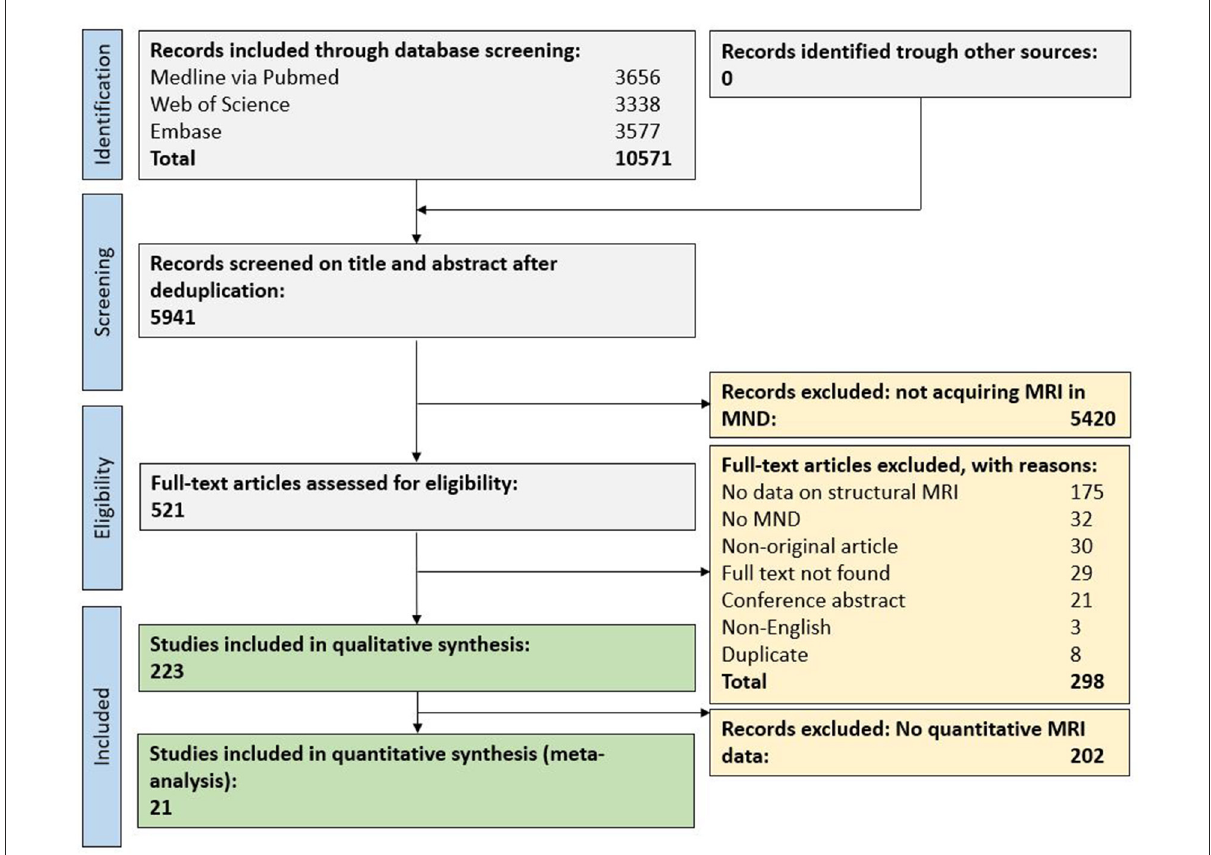
FIGURE1 Flow chart for study inclusion. MND, motor neuron disease; MRI, magnetic resonance imaging.